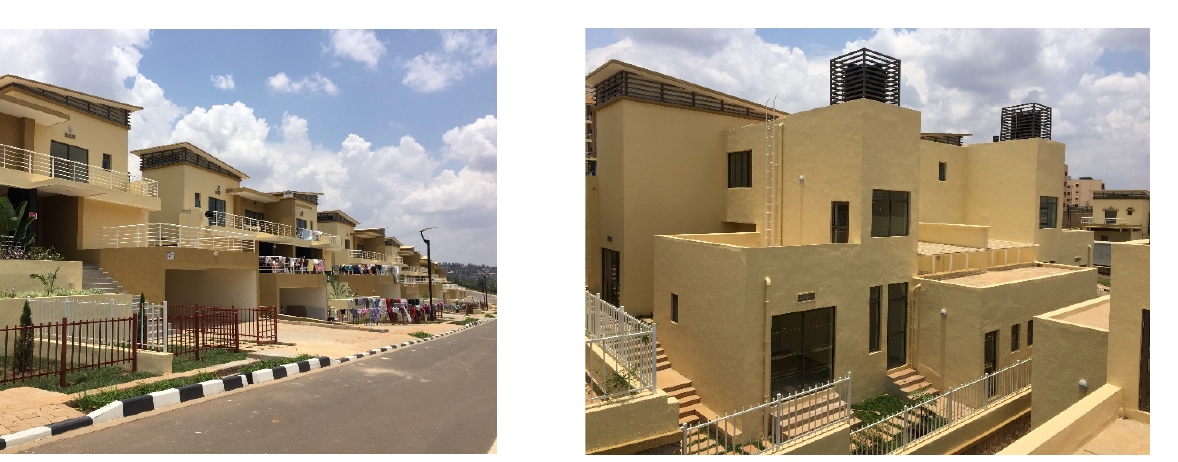
Figure 58. The Umudugudu Kigali Vision: Twin houses; back yard. Photograph by Manlio Michieletto.